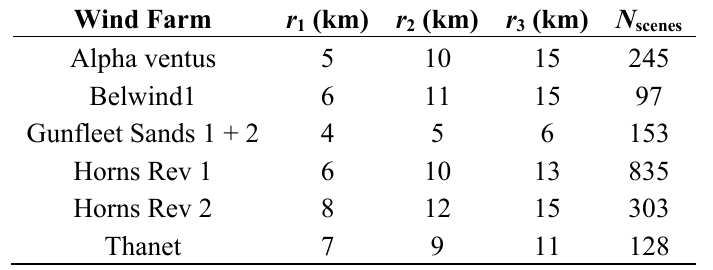
Table 4. The radii of the three concentric circles for the different wind farms and the number of Envisat ASAR scenes used for the